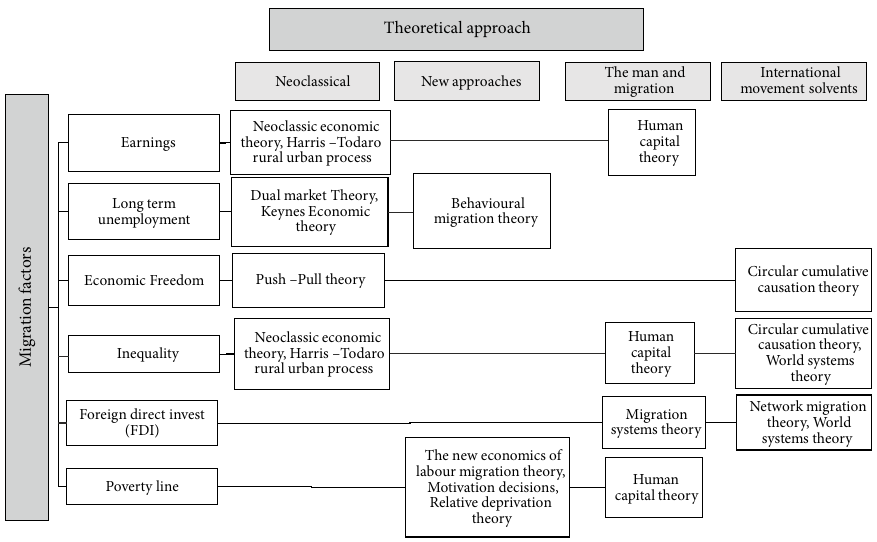
Fig. 1. Socio-economic factors of migration and from different theoretical